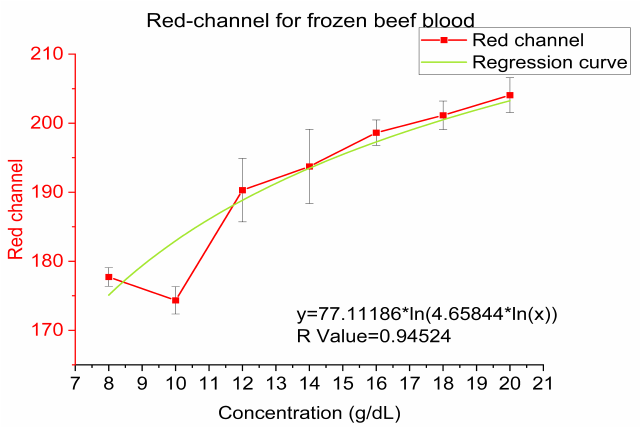
Figure 7. Red-channel value and regression for frozen beef